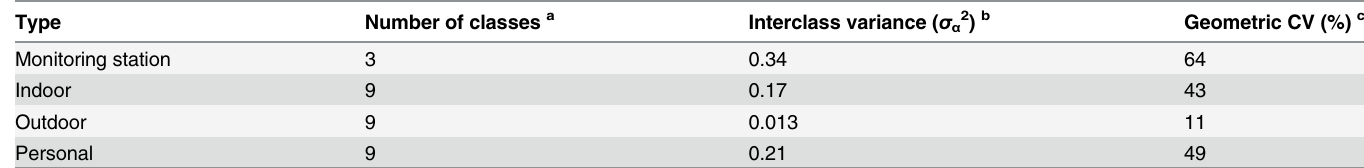
Intercept variances were calculated by the mixed models assuming the monitoring stations or the human subjects as random effects and the measurement days as fi xed effects. The natural-log-transformed pollen concentrations (pollens m -3 ) or counts (pollens cm -2 day -1 ) were used for the mixed models. c Geometric coef fi cient of variation (CV) was calculated according to eq